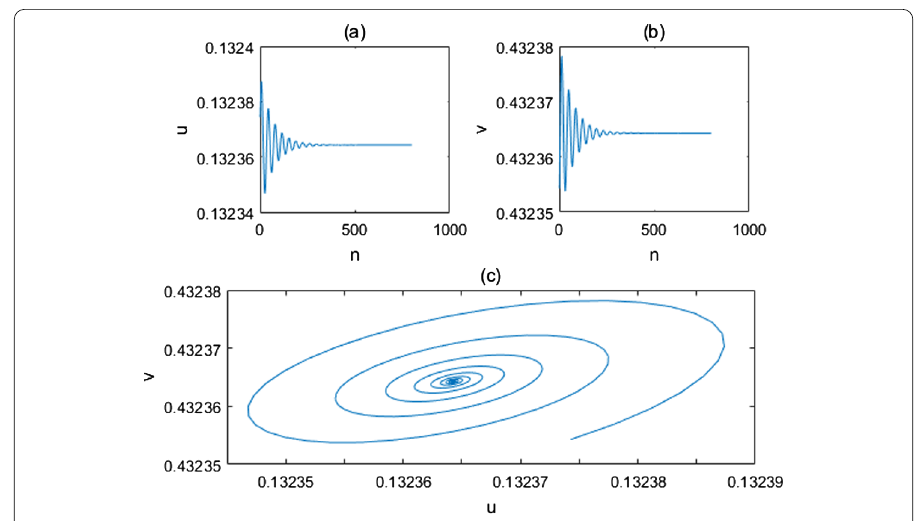
Figure 3 s = s 1 + 0.03903650778, the fixed point (0.13236426,0.43236426) is